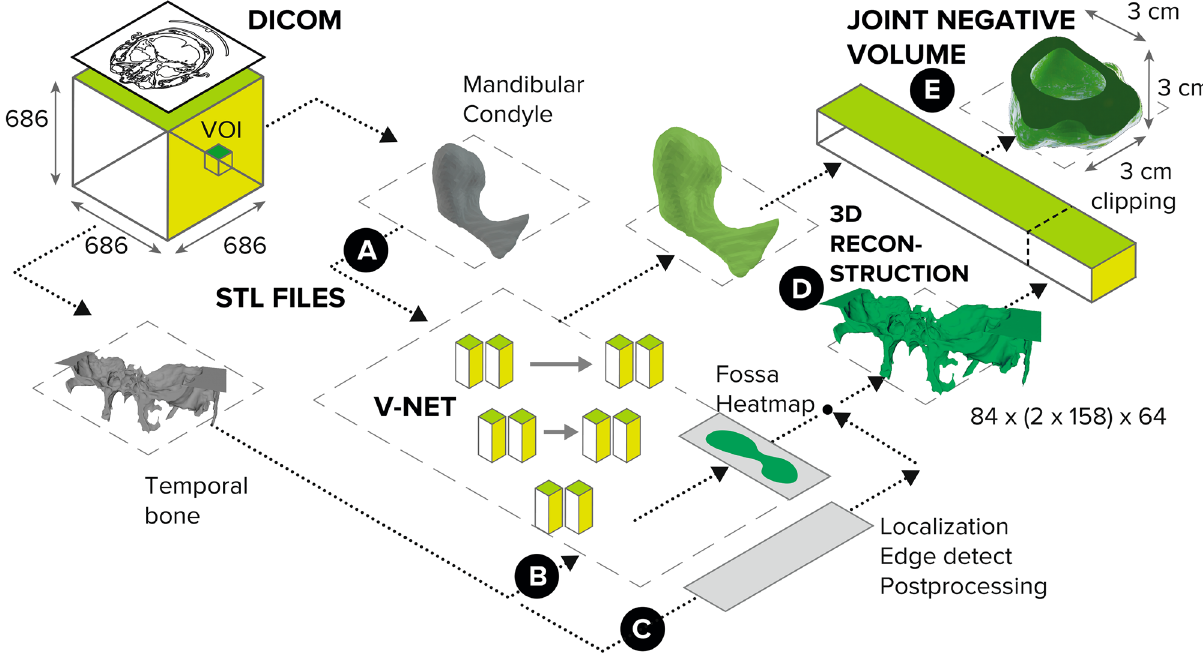
Figure 2. End-to-end pipeline for Deep Negative Volume Segmentation in joints. Segmentation of MC and TB are shown as step A and step B, respectively. Step C and step D represent classical image enhancement of both bone reconstructions. Fig. 3 shows “inflation/clipping” block (step E) in detail. Figure created with Incscape v.1.1, https:// inksc ape.